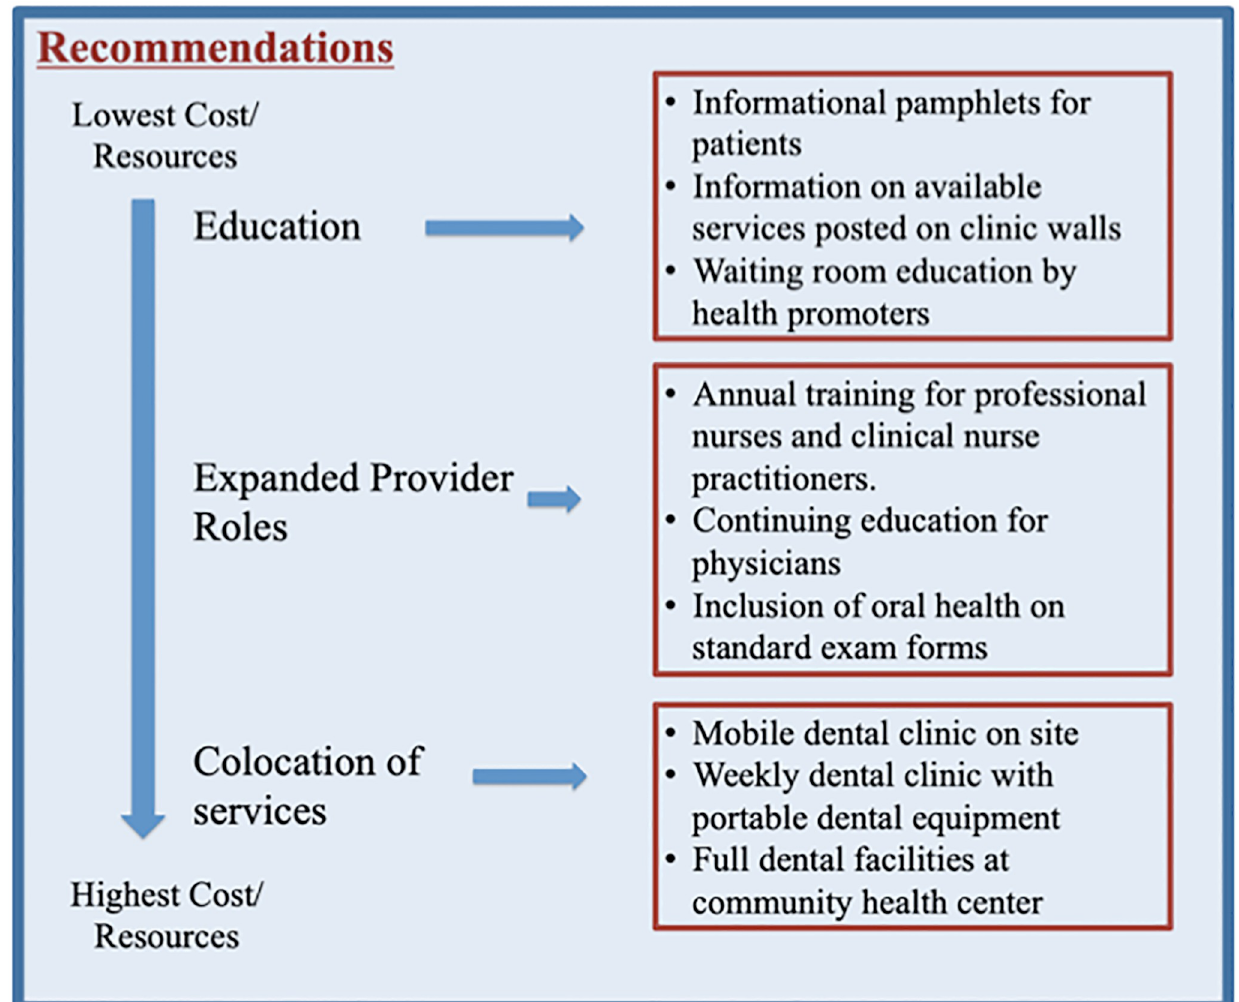
Fig 1. Proposed interventions categorized by level of required resources. These interventions are based on participants’ ideas not all of which were included in the representative quotes used in the